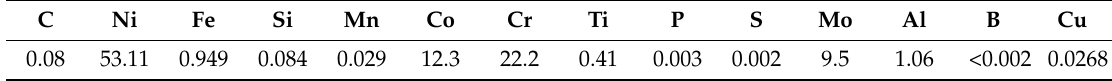
Table 1. The chemical compositions of Alloy 617 (wt